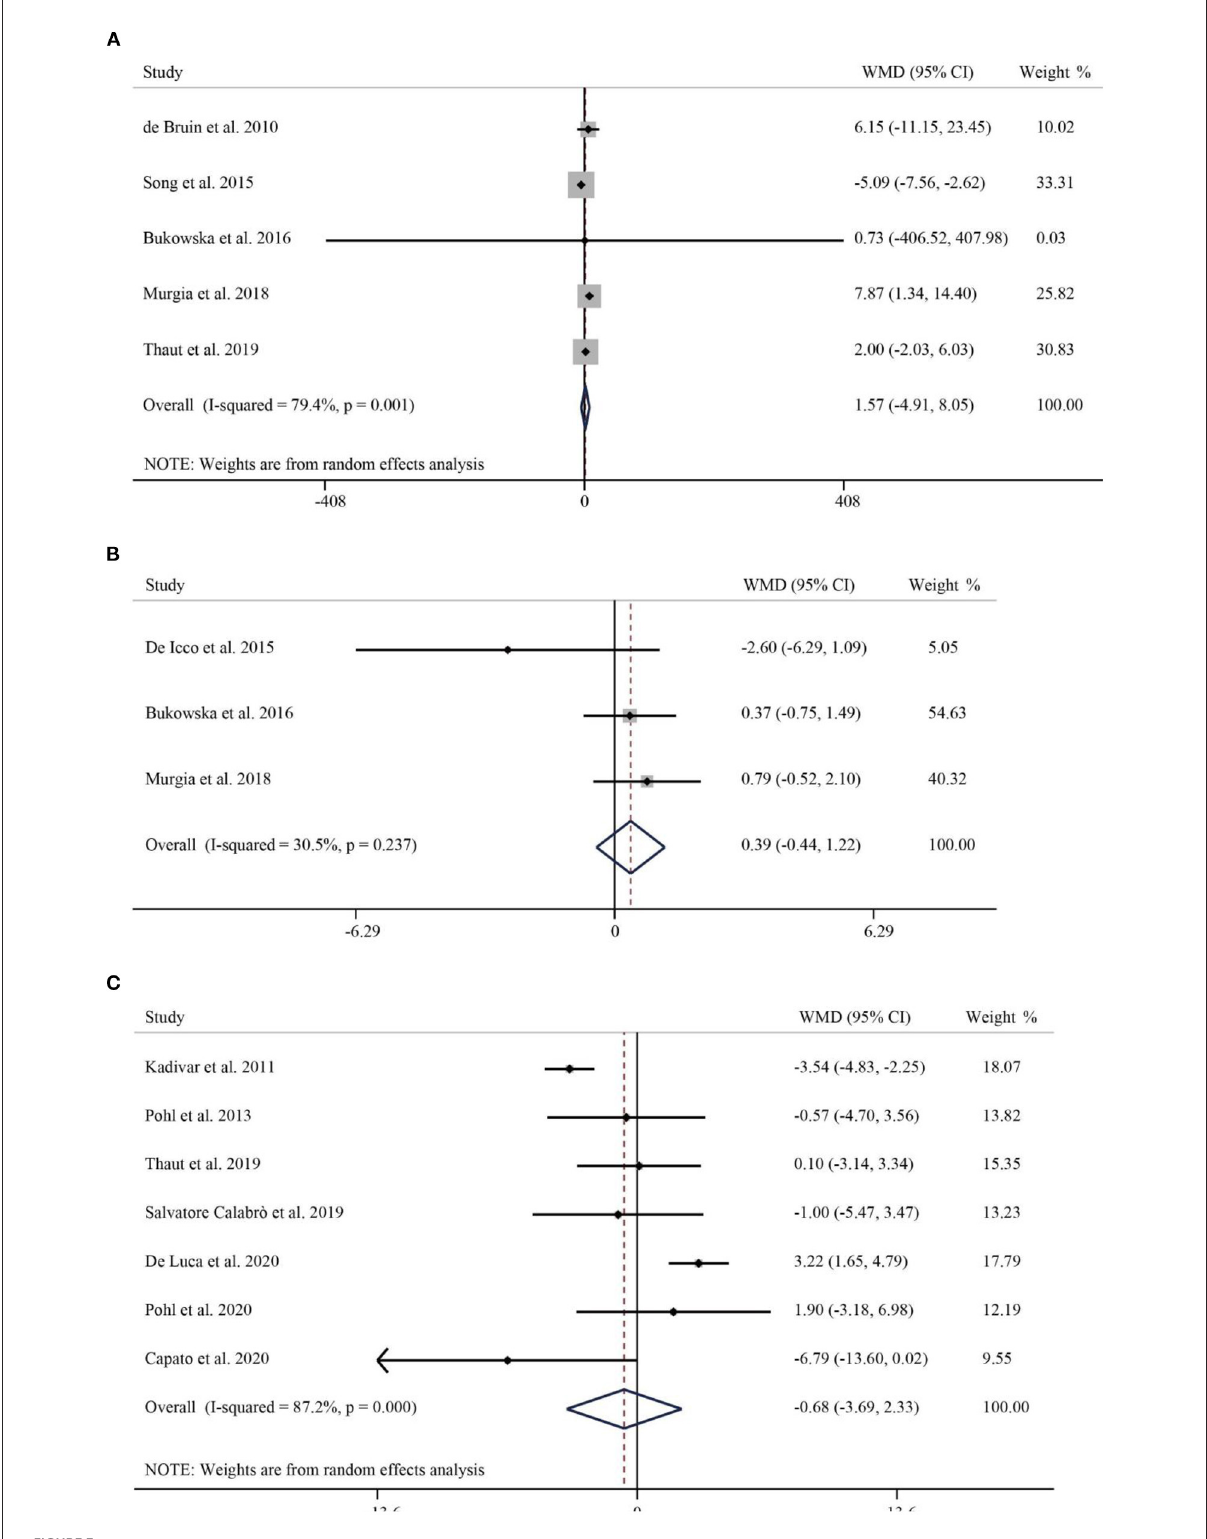
FIGURE3 Forest plot of RAS vs. the control group for step frequency (A) , swing (B) , and TUG (C). TUG, Timed